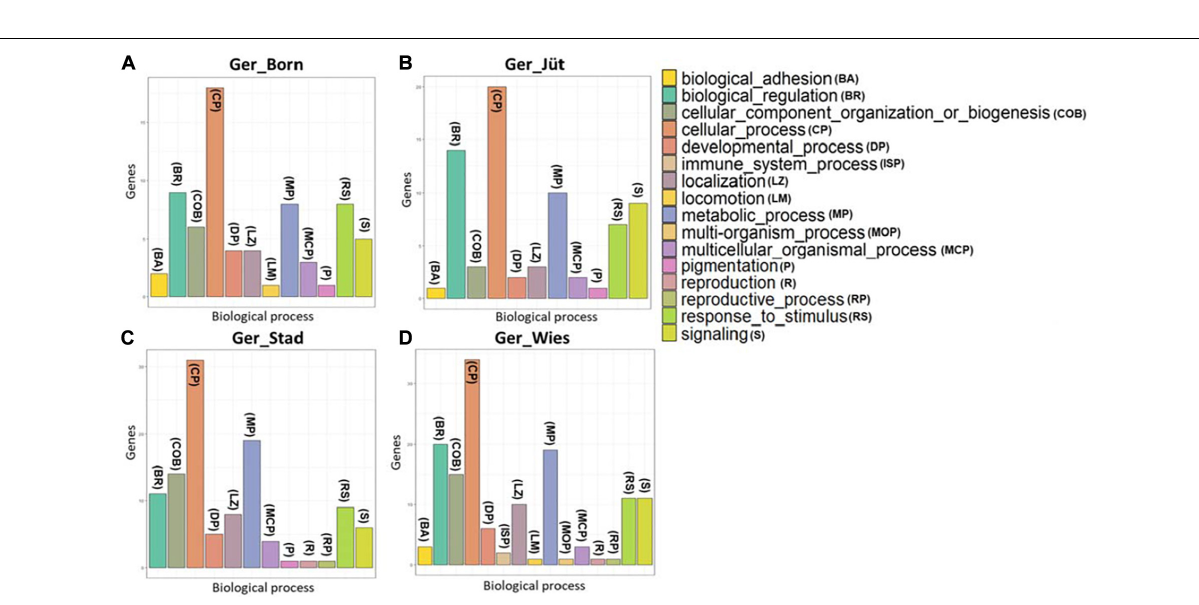
Frontiers in Genetics |